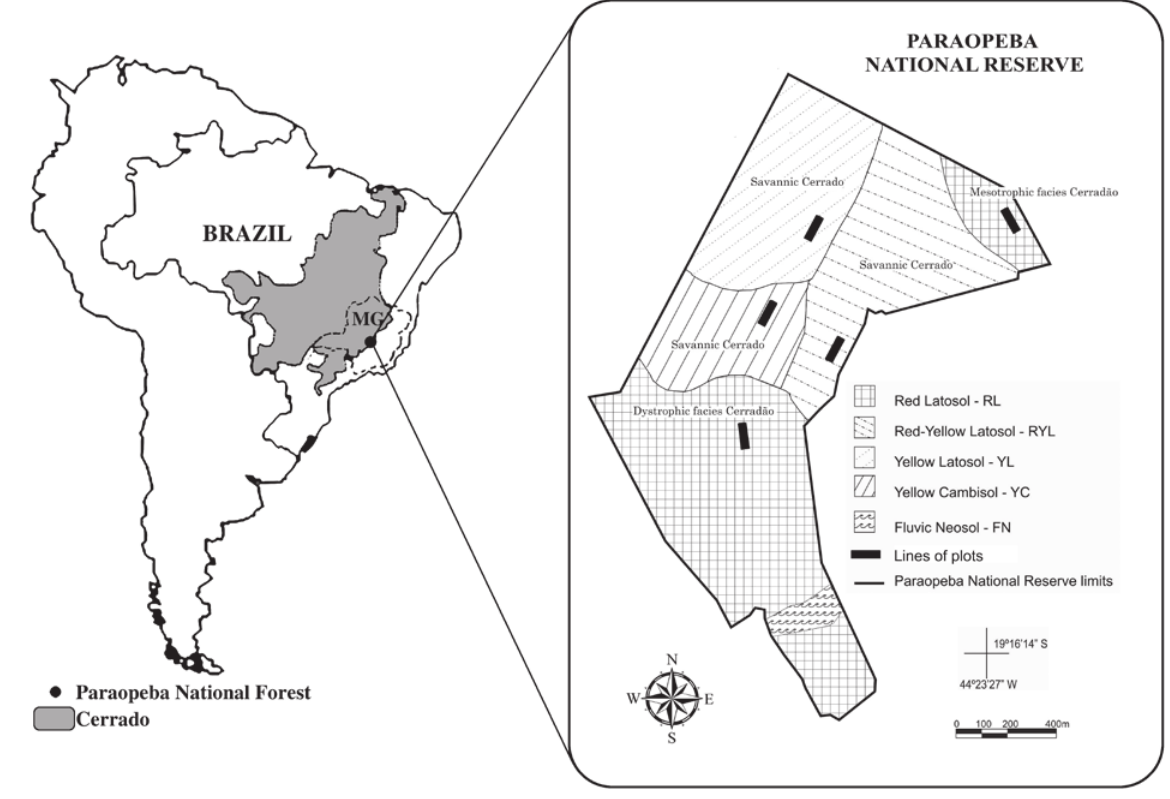
Figure 1 - Location of Paraopeba National Reserve in South America (WGS 84).